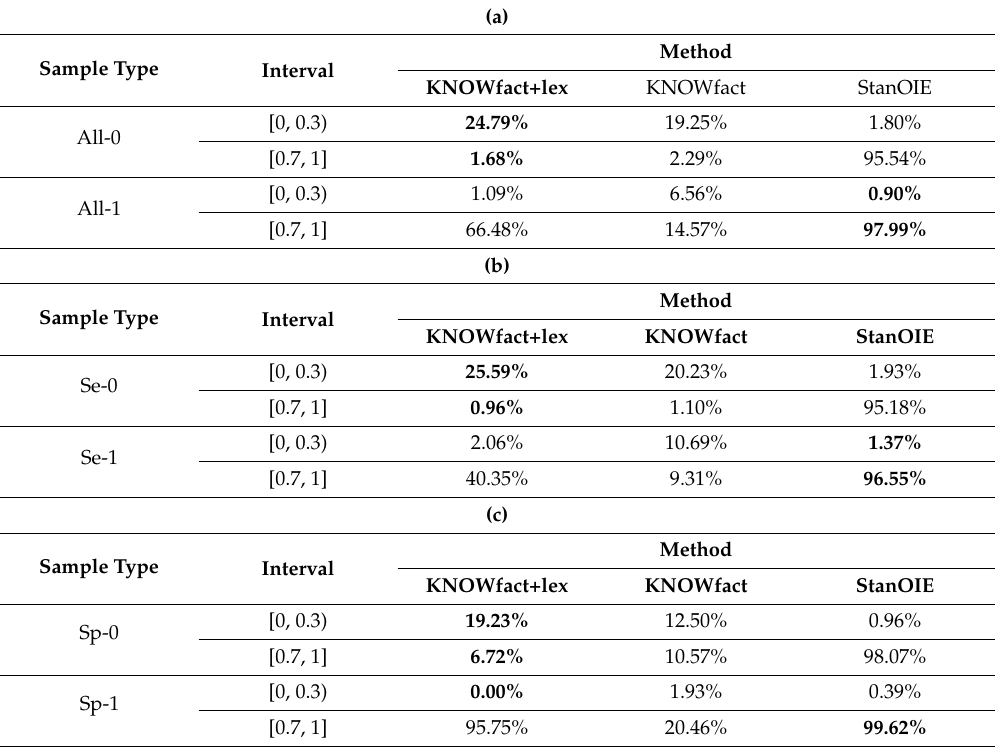
Table 3. ( a ) Percentages of the predictions for all samples; ( b ) percentages of the predictions for semantic relation samples; ( c ) percentages of the predictions for spatial relation